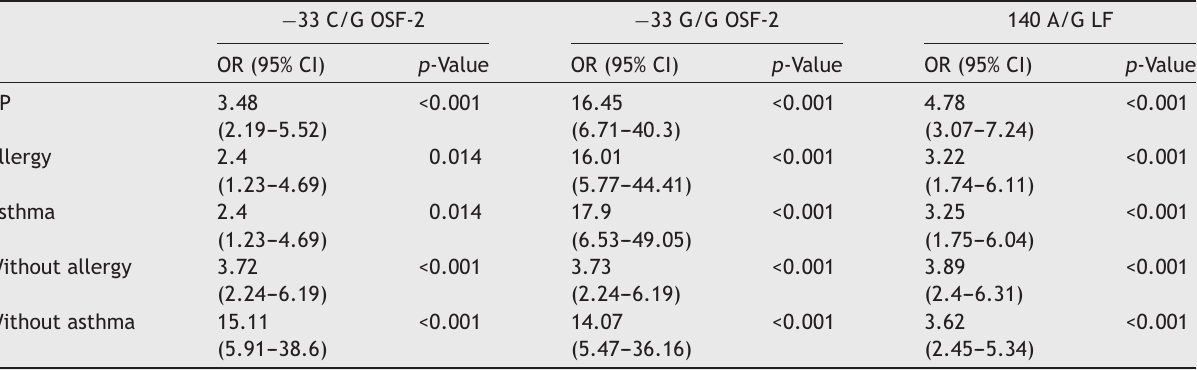
Table 7 Odds ratio (OR) and 95% confidence intervals (CI) for the associations between OSF-2 ( − 33 C/G and − 33 G/G) and LF polymorphisms and NP phenotypes with and without allergy or